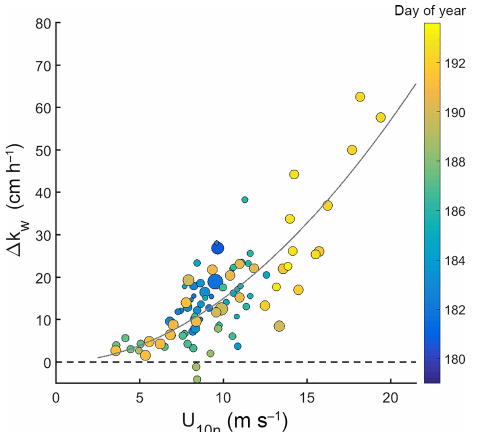
Figure 6. Difference ( (cid:49)k w ) between 2h average k CO plotted against U 10 . Data are coloured by the date of measurement (Day of Year). Sea surface temperature (SST) is indicated by sym- bol size (range is 7.1 to 12.5 ◦ C). The solid grey line describes the power law fit to the data (see Eq. 7).